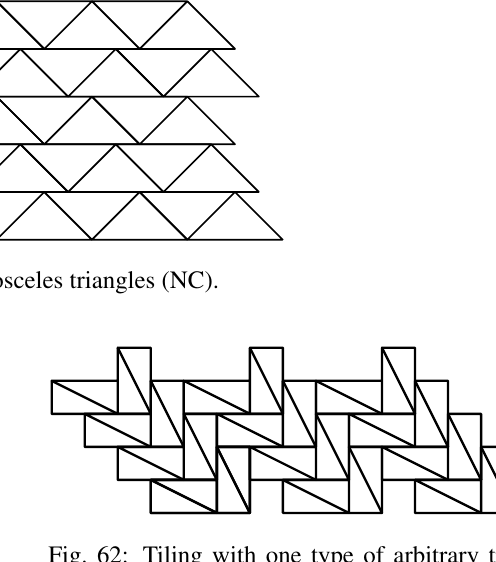
Fig. 62: Tiling with one type of arbitrary tri- angle. Two triangles in the vertex corona share an entire long edge, in the other two a medium edge touches a short